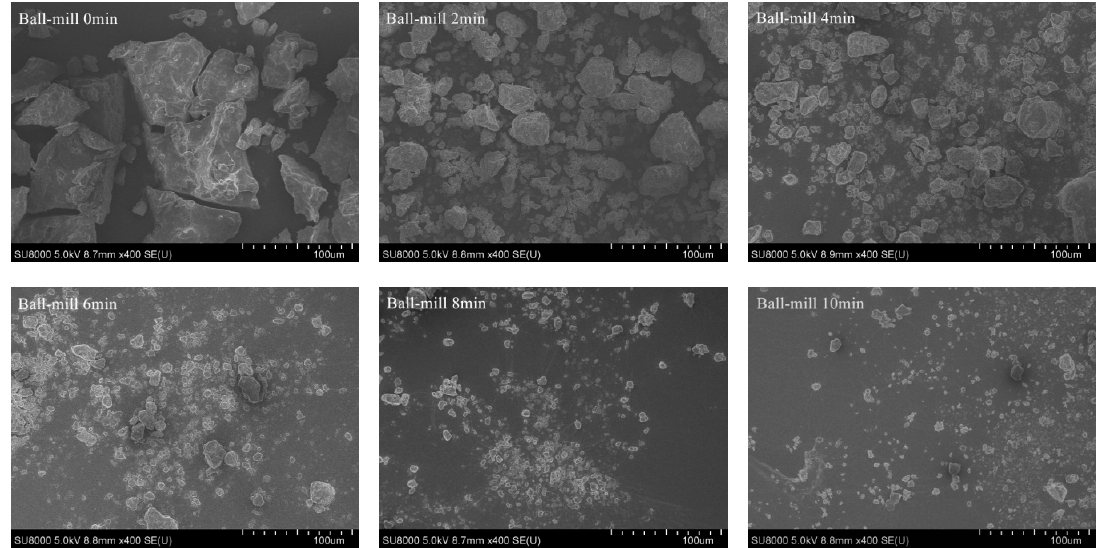
Figure 2. Effects of ball-milling time (0, 2, 4, 6, 8, and 10 min) on the microstructure of CFP.